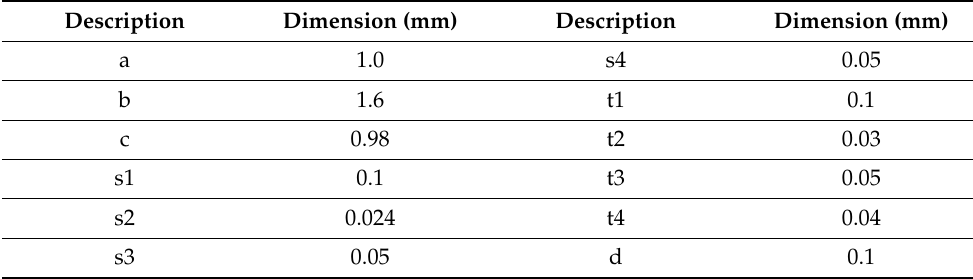
Table 1. Dimensions of element